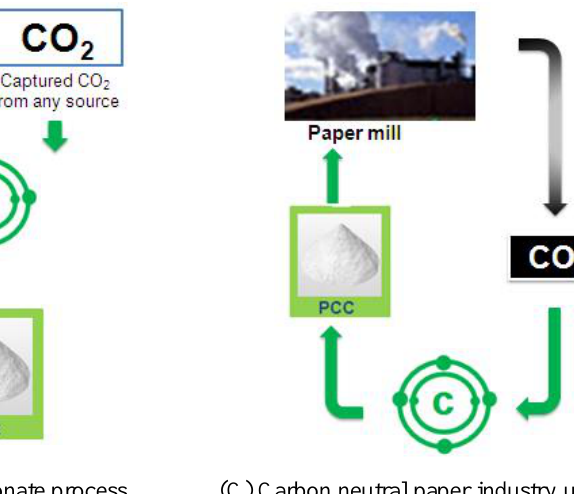
Figure 15. Schematic of PCC manufacture process and application to the paper